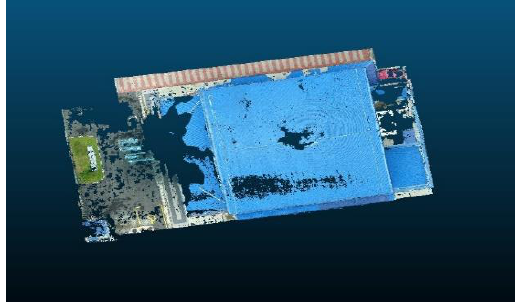
Figure 5: Scalar-Based Segmentation of the asset